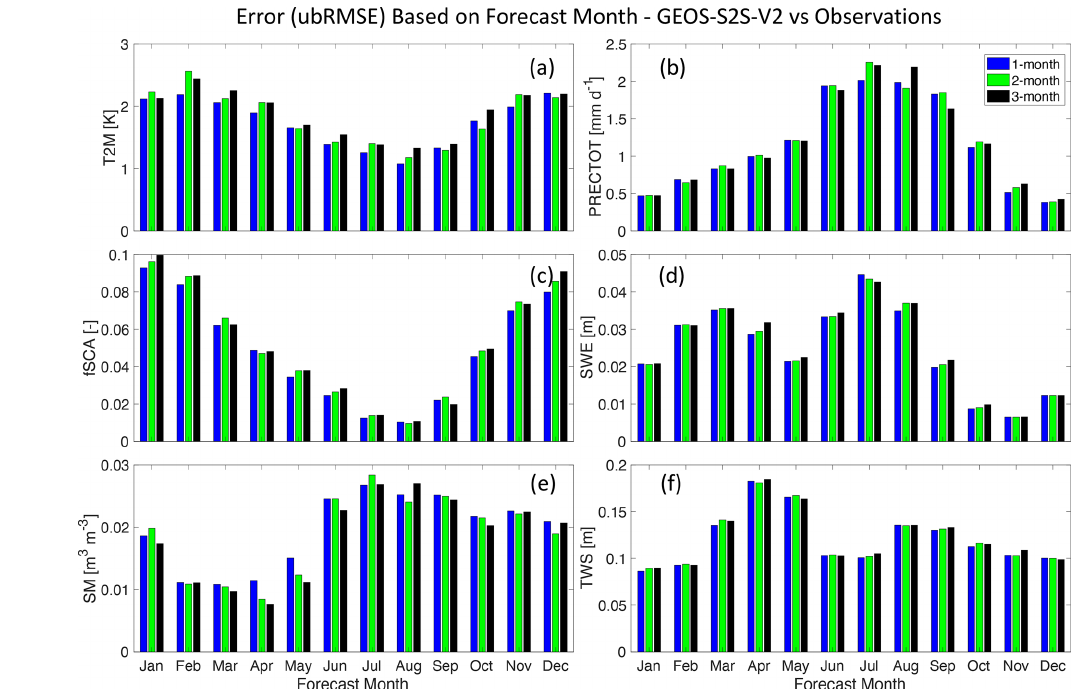
Figure 6. Same as Fig. 5, but the results displayed in this figure use the reference data products as the evaluation target. The data that are used in this figure are as follows: ERA5 for T2M, APHRODITE for PRECTOT, MODIS for fSCA, HMA-SR for SWE, ESA-CCI for SM, and GRACE for